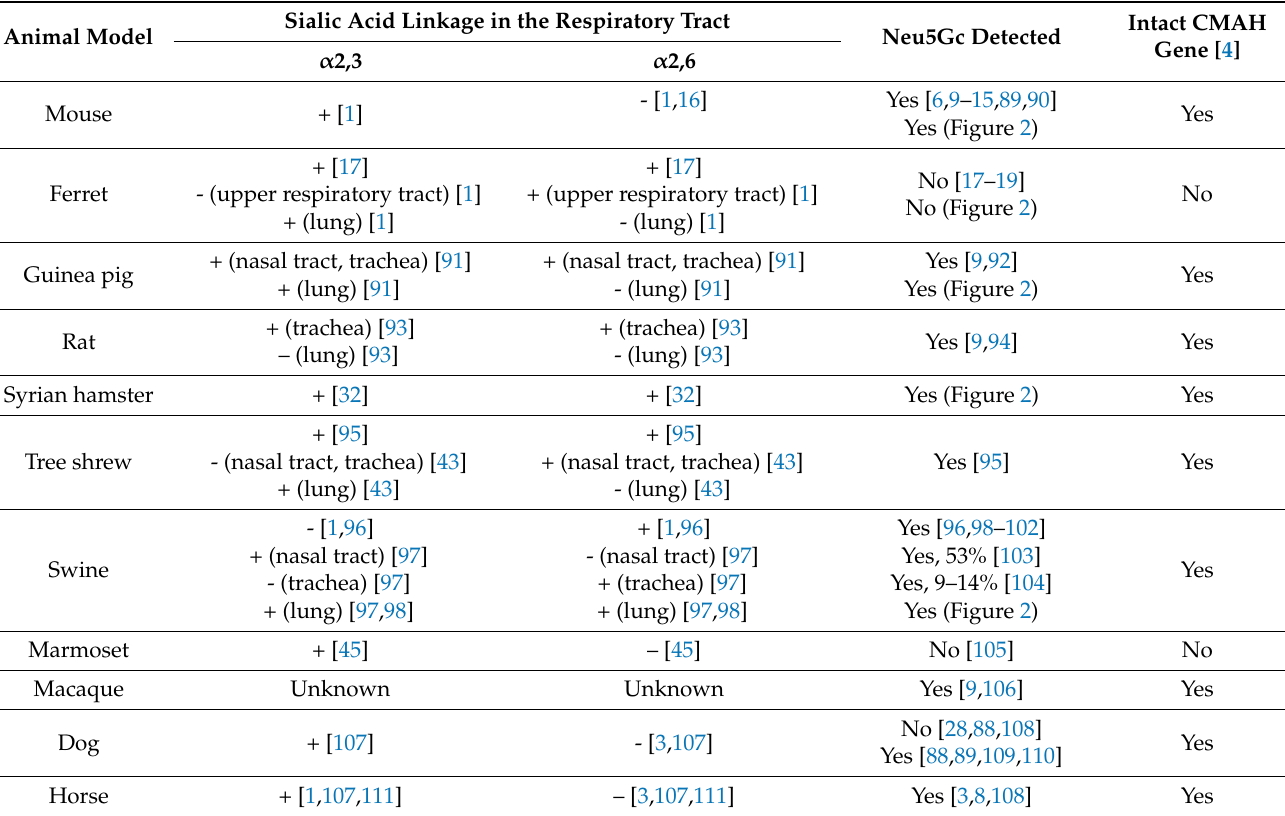
Table 1. Overview of sialic acid linkages in the respiratory tract, the presence of Neu5Gc, and the presence of an intact CMAH gene in different animal models. +: high levels, -: low levels, –: not detected. Animal